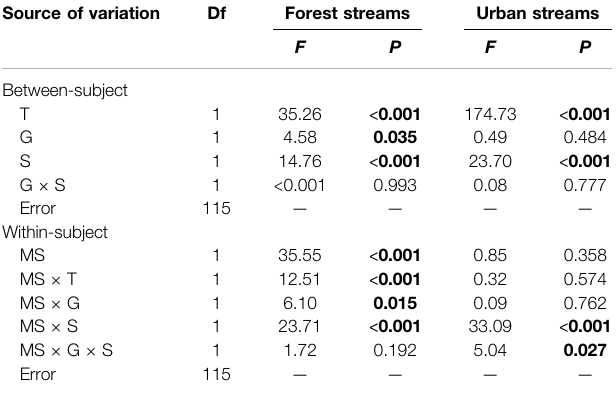
TABLE 1 | Results of general linear model comparing leaf litter breakdown rates (day − 1 ) in coarse and fi ne mesh bags across treatments of glyphosate (G) and carrion subsidy (S). Mesh size (MS) was “ within-subject ” factor ( fi xed), glyphosate and carrion subsidy were “ between-subject ” factors ( fi xed), and sampling date (T) were treated as covariate. p values < 0.05 are shown in bold.